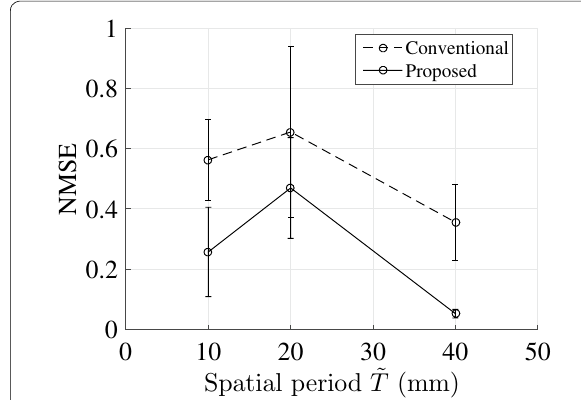
Fig. 10 Graph showing the relationship between spatial period ˜ T